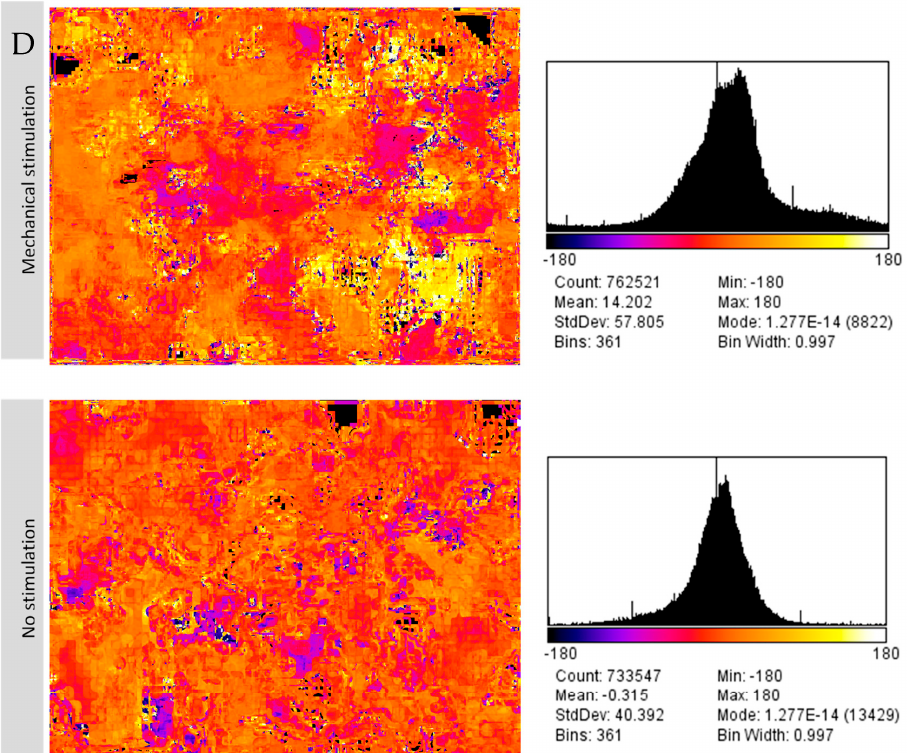
Figure 6. The expression of α -actinin and connexin-43 in neonatal cardiac cells cultured in 3D dECM-fibrin hydrogel under mechanical stimulation and static condition (without mechanical stimulation). ( A ) The immunofluorescence staining of the neonatal cardiac cells, ( B ) the area of the expression (red area) to the whole area of the image. This ratio was considered as the expression percentage. ( C ) Local frequency of neonatal cardiac cells cultured in 3D hydrogel, with and without mechanical stimulation (left). An unpaired t -test analysis (two-tailed, equal variances) of these data shows no significant difference between the two groups. ( D ) Local phase distribution with and without mechanical stimulation (right). An unpaired t -test analysis (two-tailed, equal variances) of these data shows no significant difference between the two groups. Error bars represent the mean ± standard deviation (SD) of the measurements (** p < 0.01, *** p < 0.001).